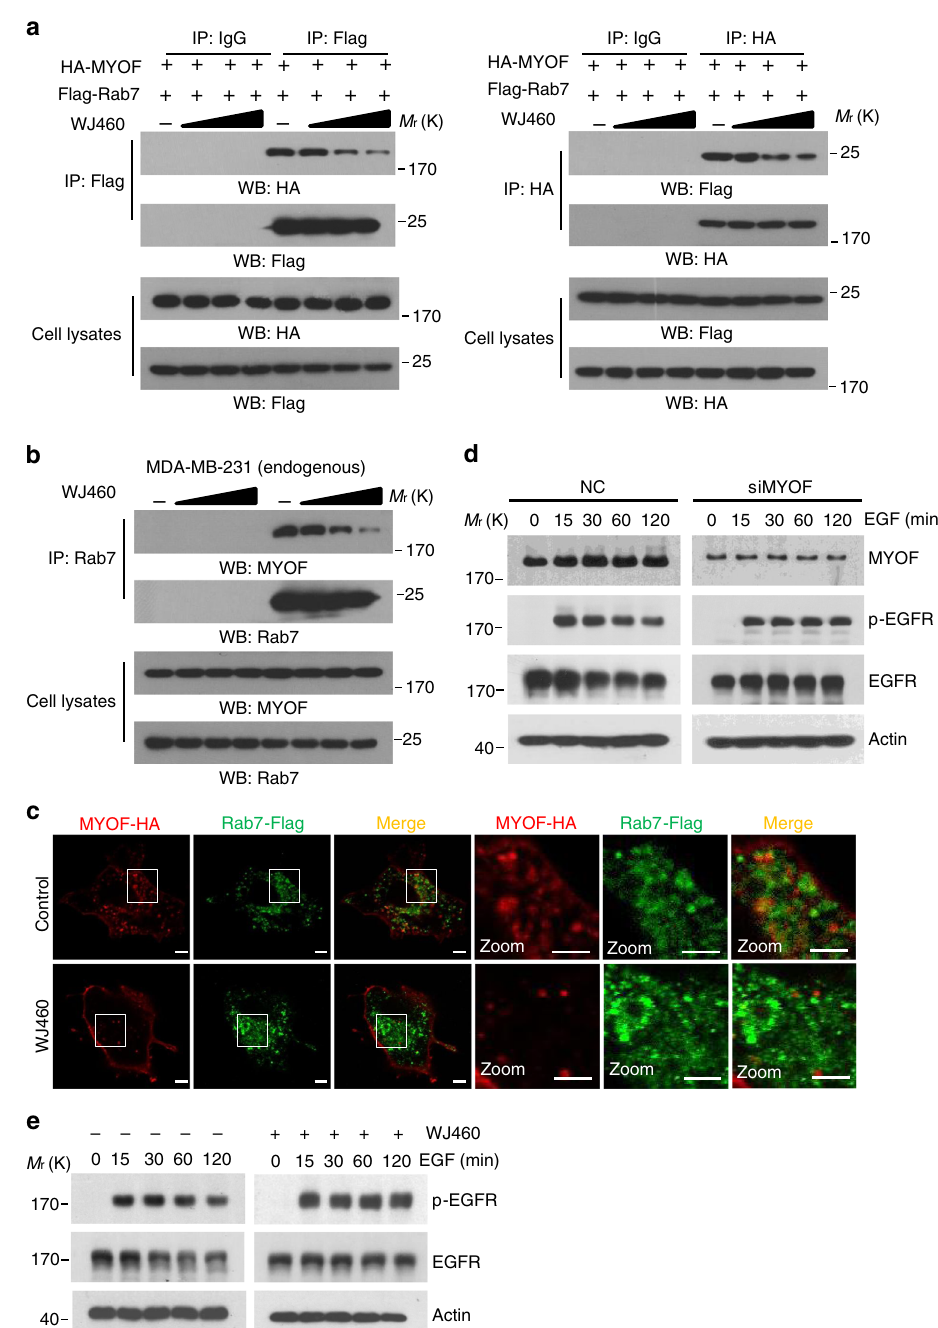
Fig. 5 WJ460 facilitates the dissociation of MYOF in Rab7-positive late endosomes. a HA-MYOF and Flag-Rab7 were co-transfected in 293T cells. Cells were then exposed to increasing concentrations of WJ460 (50 nM, 100 nM and 200 nM). Immunoprecipitation assays were performed using anti-Flag M2 gel or anti-HA gel ( n = 3). b MDA-MB-231 cells were treated with increasing concentration of WJ460 (50 nM, 100 nM and 200 nM) and a co-IP assay was performed with anti-Rab7 antibody ( n = 3). c 293T cells co-transfected with HA-MYOF and Flag-Rab7 were treated WJ460 (100 nM). Cells were then fi xed and stained for HA (red) and Flag (green) ( n = 3). Scale bars, 10 μ m. d Time-dependent phospho-EGFR and EGFR expression following EGF stimulation with or without myoferlin knockdown. e Time-dependent phospho-EGFR and EGFR expression after EGF stimulation with or without WJ460 exposure ( n = 3). In each panel, n indicates the number of independent experiments